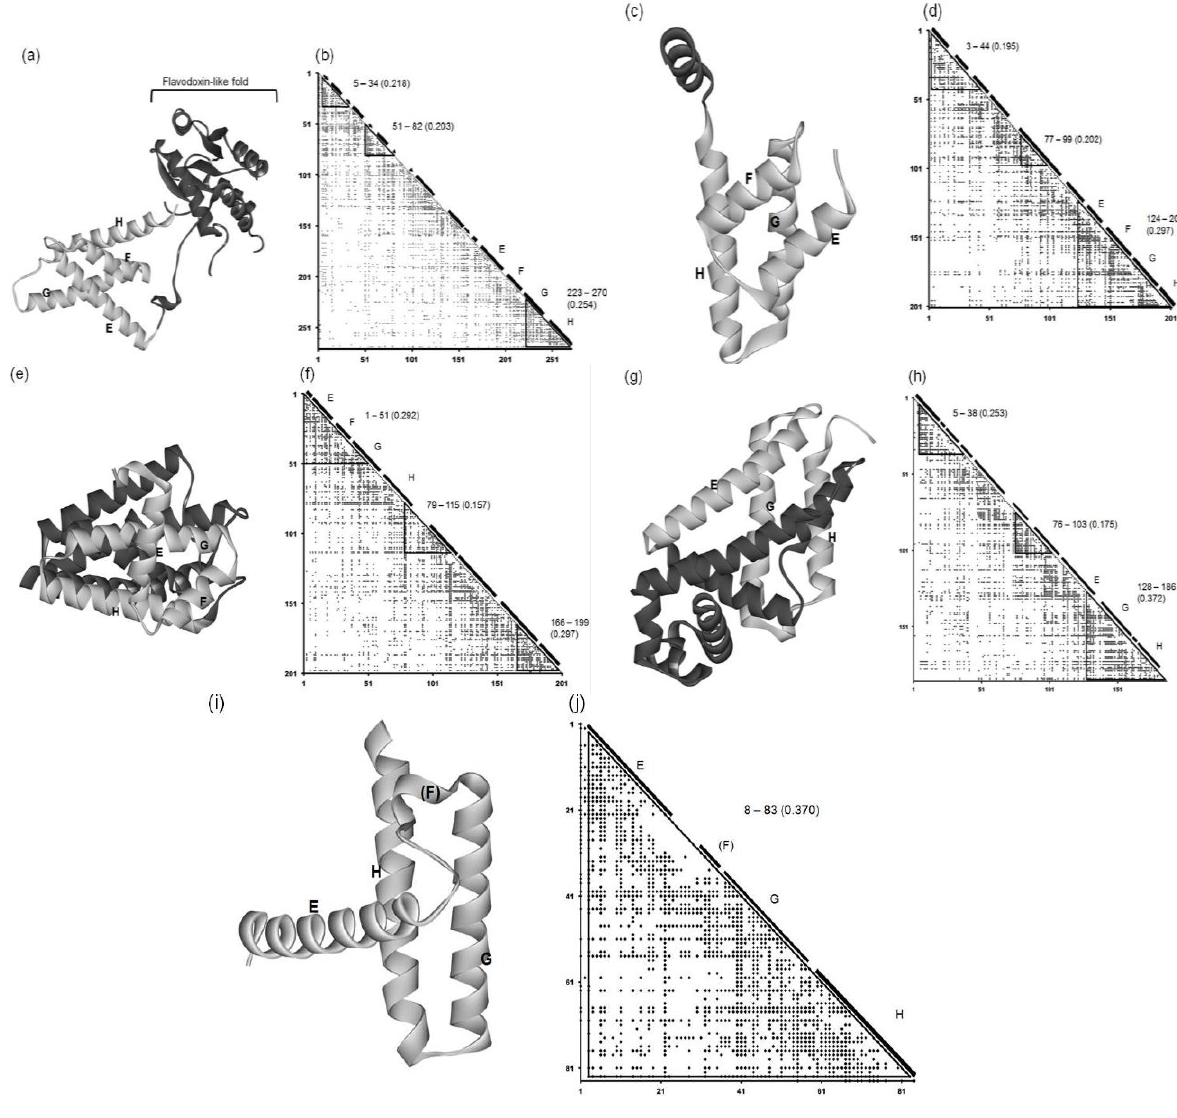
Figure 6. 3D structures and ADMs of 1R8J ( a ) and ( b ), 1XL3( c ) and ( d ), 2FM9 ( e ) and ( f ), 2NP5 ( g ) and ( h ), and 2P06 ( i ) and ( j ). A portion in light gray denotes the corresponding E-to-H helix part. The label “5–34” denotes the compact region predicted by ADM. The numeral in parentheses means the  value of a compact region predicted by